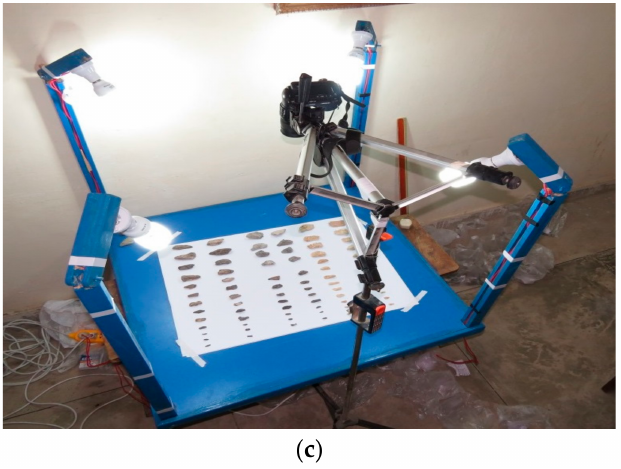
Figure 2. ( a ) Front & top view, ( b ) 3 Dimensions, ( c ) Image capturing system. The three dimensions or axis, such as longest, shortest, and intermediate axis val- ues, are measured for each particle. The three axes of aggregate particles follow the 3-D dimensions of a rectangle as described in the literature [25]. There are three dimensions, i.e., as longest (length), intermediate (width) and shortest axis (thickness) of each particle. The aggregates were arranged in a stable position, and two images from the top view (for longest and intermediate axis) and front view (shortest axis) were captured to calculate these dimensions. Both images were imported in the Image-J software, and three dimen- sions were computed by processing them. The details of the image capturing system are presented in Figure 2 step by step in Section 2.1. The image processing and analysis is described in Section 2.2 and Figure 3.